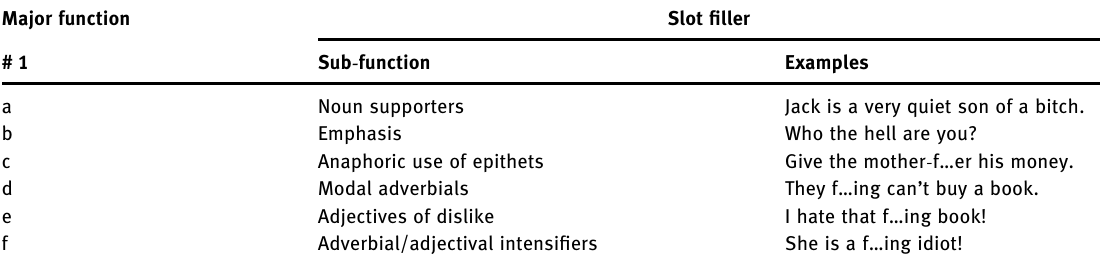
Table 1: Slot fi ller function Major